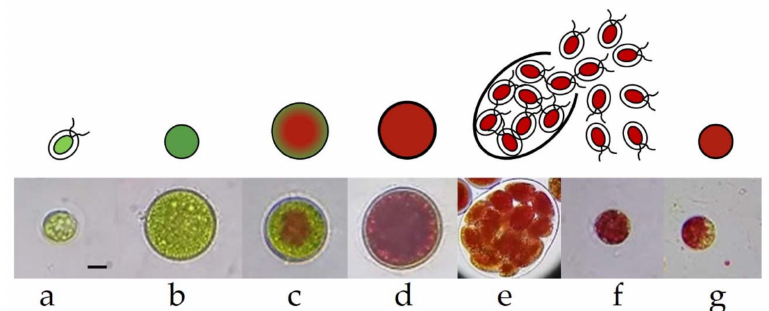
Figure 1. The cell cycle of H. pluvialis : ( a ) motile, flagellated cell, ( b ) aplanospore, ( c ) astaxanthin- accumulating aplanospore, ( d ) red cyst cell, ( e ) dividing cells (sporangium), ( f ) astaxanthin rich zoospores released from the sporangium, ( g ) aplanospore derived from astaxanthin containing zoospore. Scale bar: 10 µ